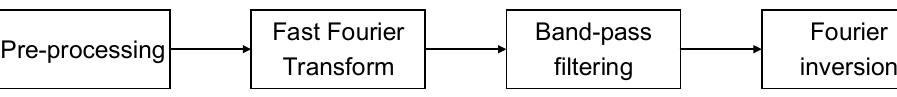
Figure 6. Flow chart of texture separation.